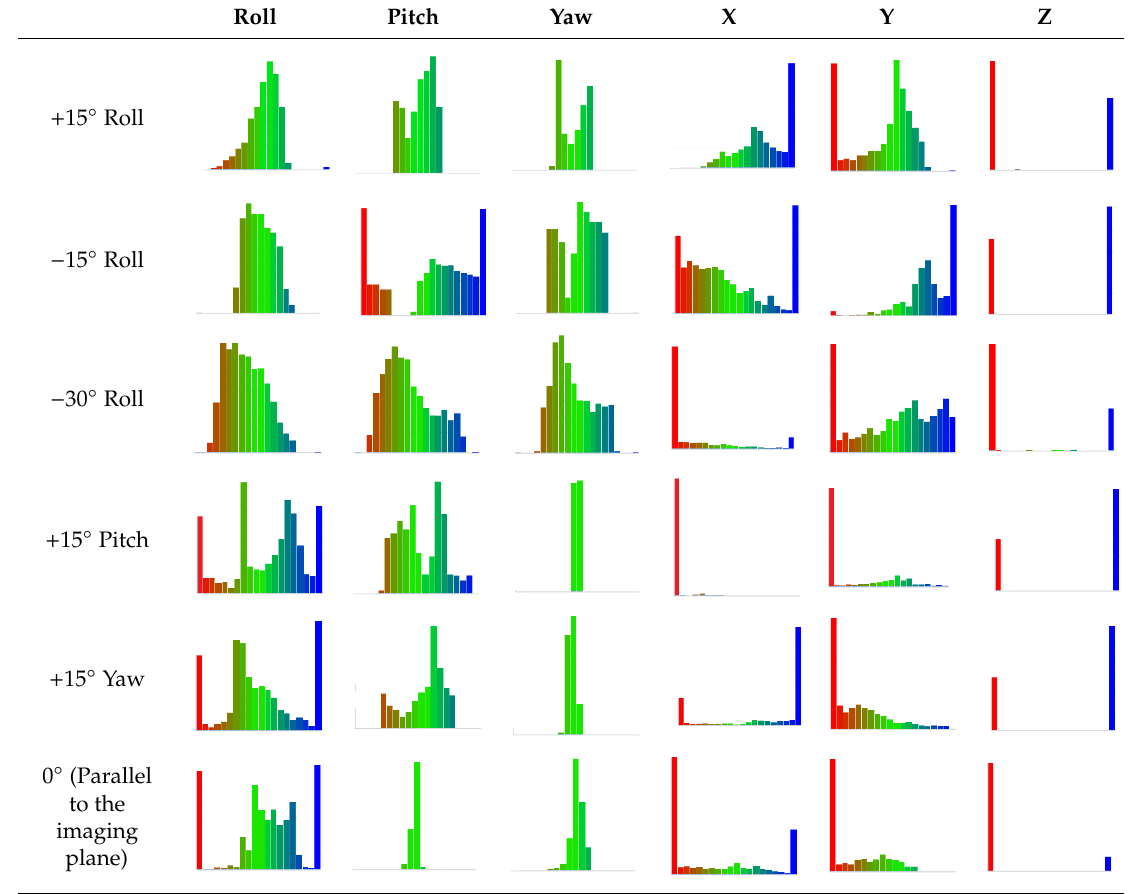
Table 4. Histogram of deviations for the 2D grid board pose estimates. The bars further from the center of the bar graph represent the count of measurements with more significant deviations.